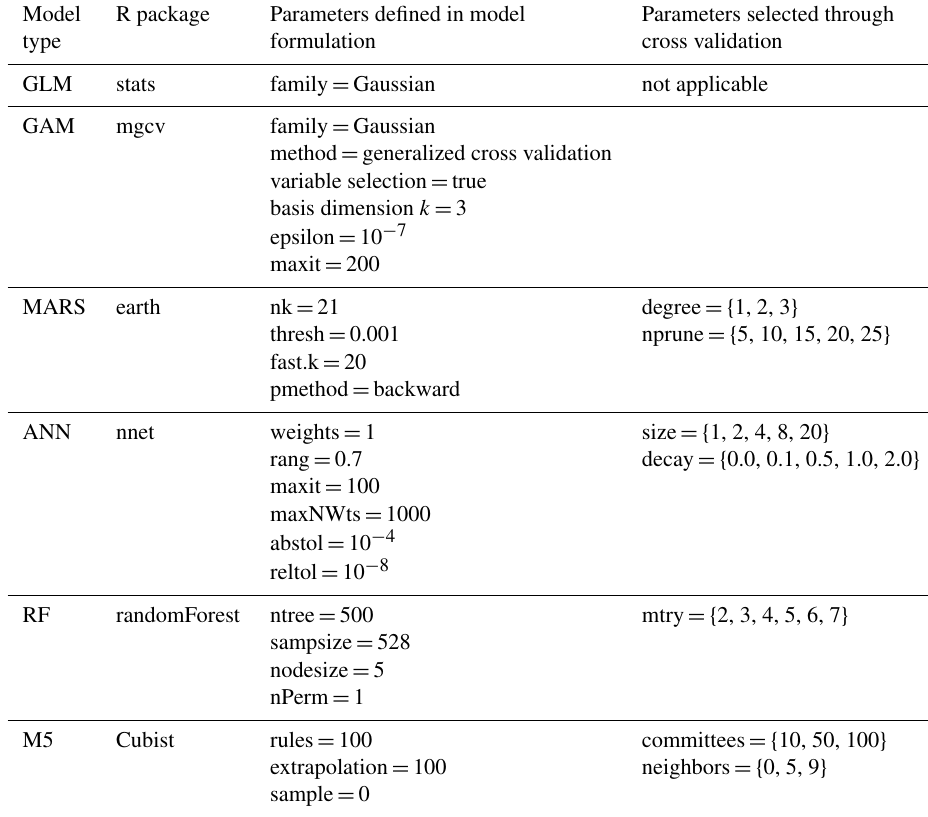
Table 2. Model parameters evaluated through cross